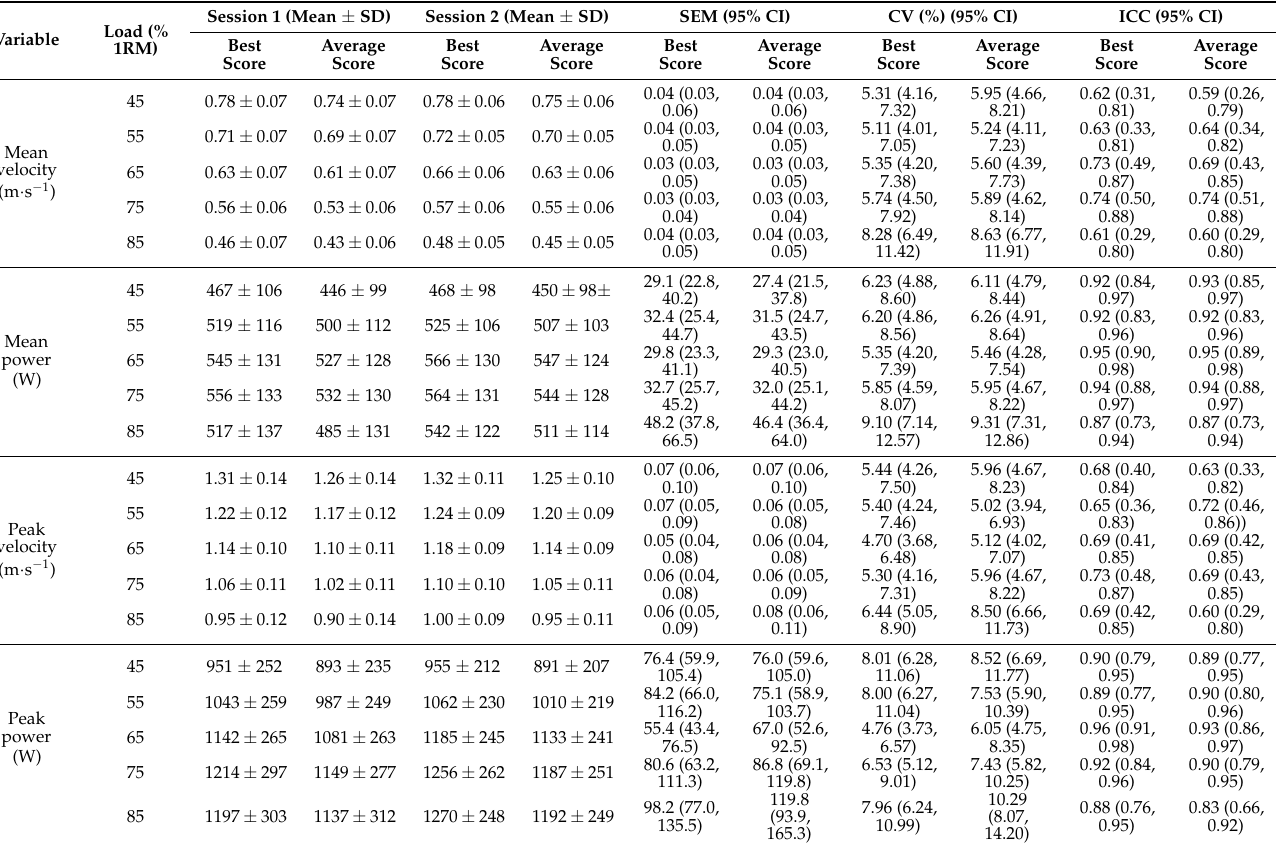
Table 2. Between-session reliability of mean velocity, mean power, peak velocity, and peak power variables obtained from the best and average scores of 3 repetitions in the back-squat exercise performed with the rebound technique at different